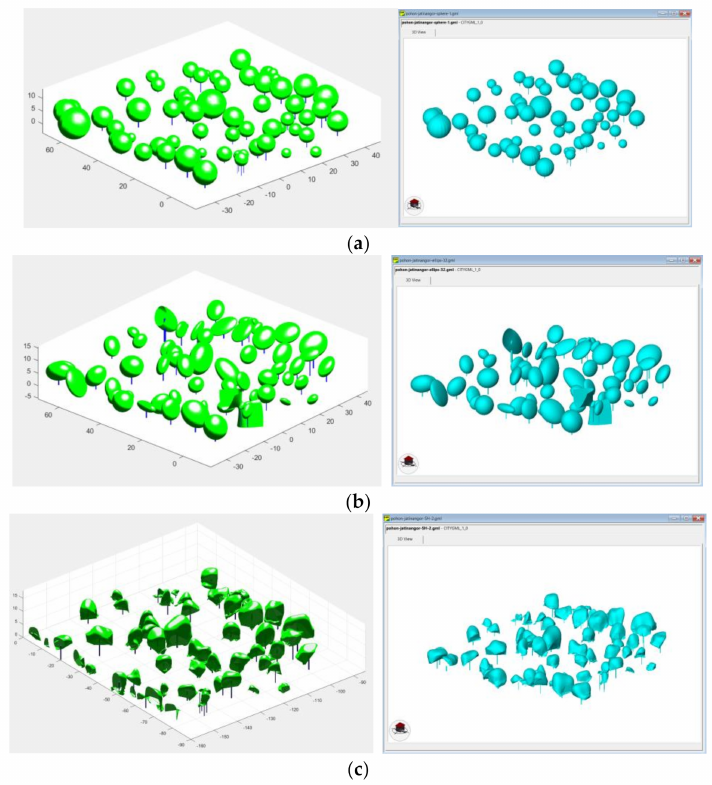
Figure 12. Conversion result of tree model in Area of Interest for ( a ) spherical fitting, ( b ) ellipsoid fitting, and ( c ) spherical harmonics fitting